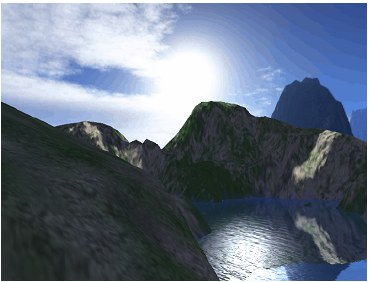
Fig. 16. Wireframe view of the surface.